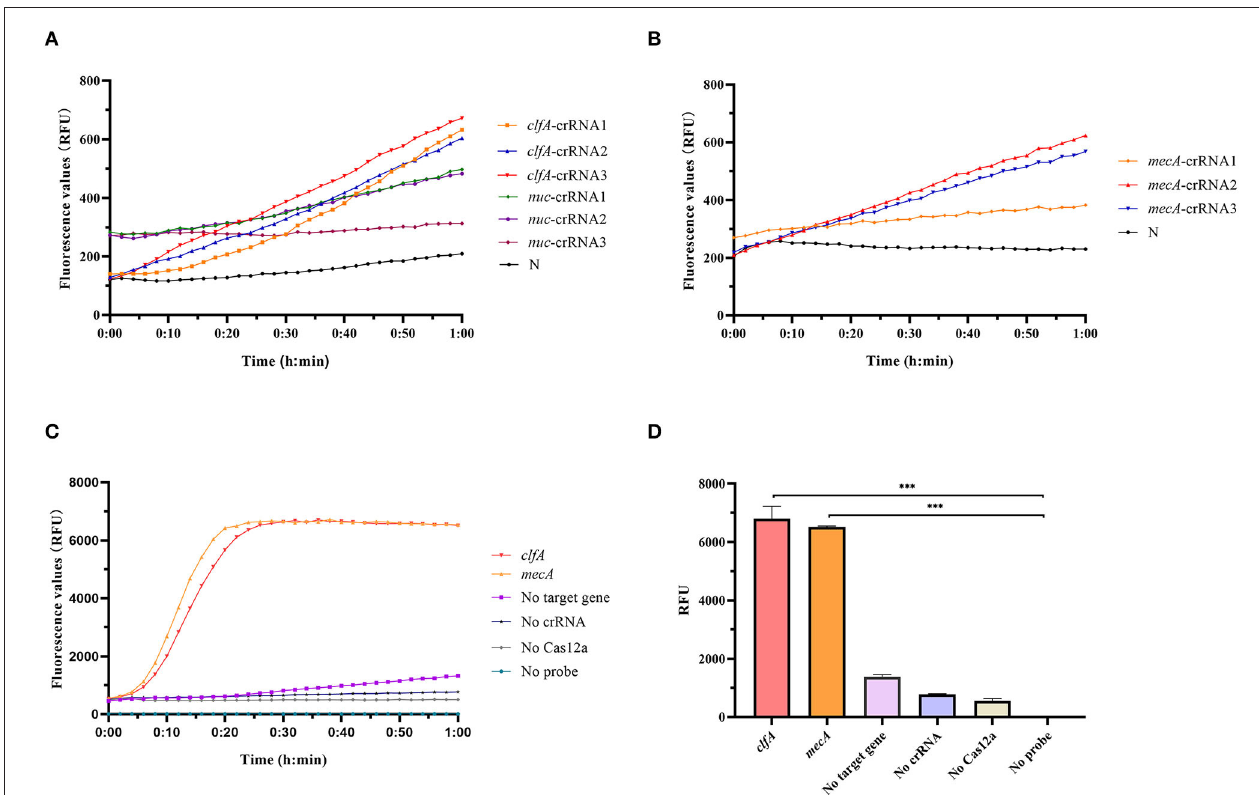
FIGURE 2 | Preparation of Cas12a detection system. (A) To screen for optimal crRNA that specifically identify S. aureus , we designed different crRNAs for nuc and clfA genes and simultaneously performed Cas12a detection for S. aureus with the same concentration without amplification. (B) Different crRNAs were designed for the mecA gene, and Cas12a detection was performed on unamplified MRSA DNA to screen out crRNA with better specificity to recognize MRSA. (C) Cas12a detection system fluorescence report curve. (D) Comparison of fluorescence values generated after 60min of Cas12a reaction, *** p < 0.0001. Data were expressed as mean ± SD ( n =